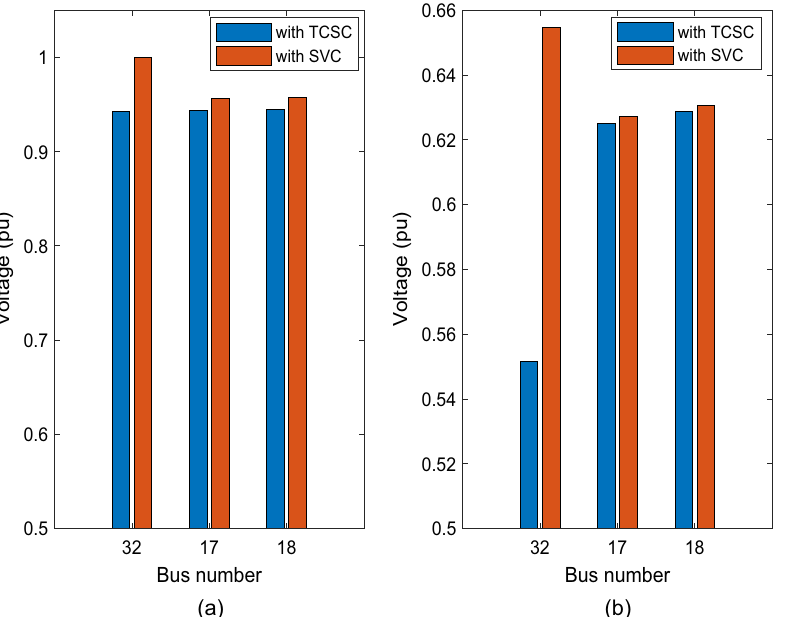
Figure 10. Voltage profile comparison when the system installed with TCSC and SVC ( a ) nominal load ( b ) heavy